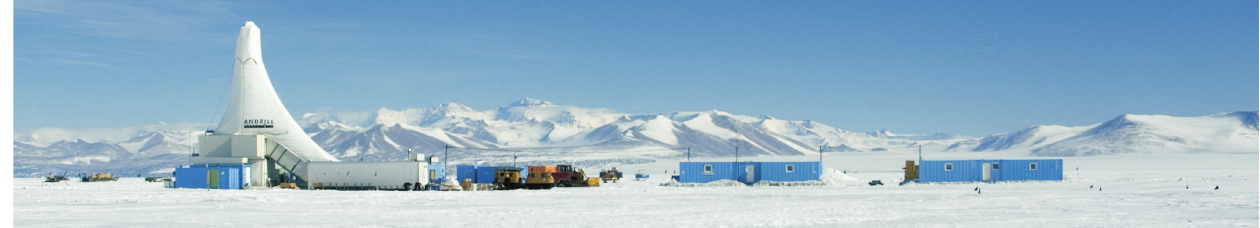
Figure 1. Panoramic image of the ANDRILL drilling rig and science laboratories in Southern McMurdo Sound during late 2007, operating from a 8.4-meter-thick sea-ice platform. Transantarctic Mountains are visible in the